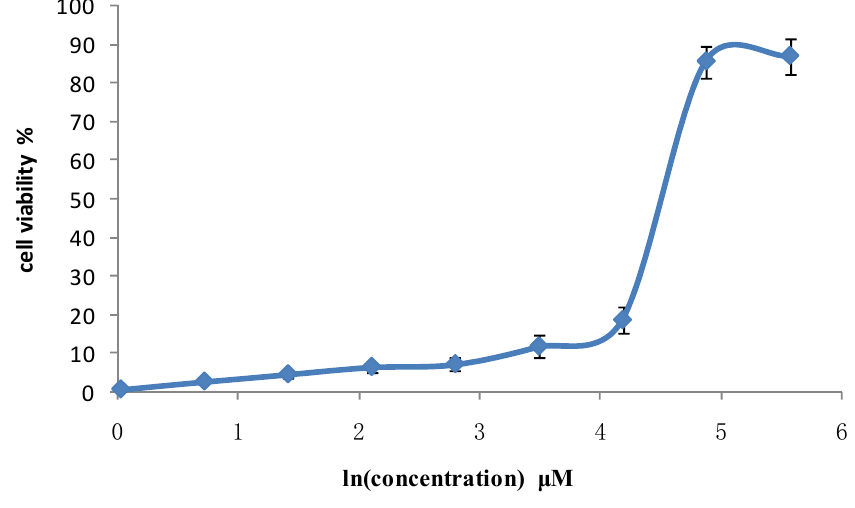
Figure 2. Anti-proliferative effects of GRg6 on human lymphocytoma JK